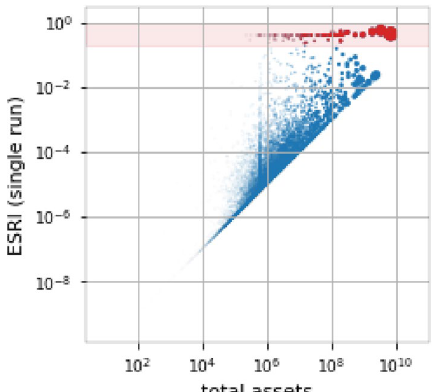
Figure 4. Economic systemic risk vs. firm size measured as total assets in log-log scale. Marker size represents total assets; companies in the “plateau” of Fig. 3c are marked red and highlighted by red shading. For a